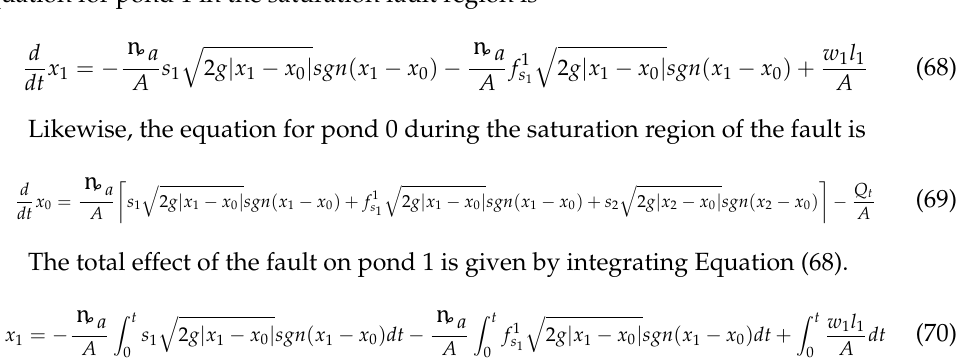
Figure 1. Three-pond hydraulic system.